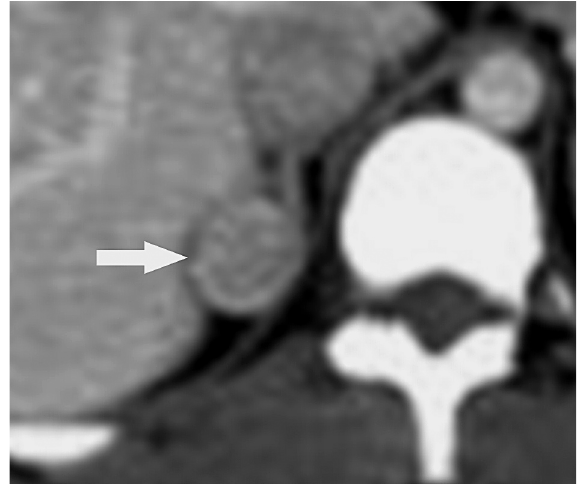
Figure 3 – A) Axial contrast-enhanced portal venous phase CT scan in a 49 year old man with melanoma (Case 3 in Table-1) shows a homogeneously enhancing left adrenal mass (arrow). B) Coronal PET image shows increased fluoro-2-deoxy-D-glucose (FDG) uptake in the mass (arrow). The patient proceeded to laparoscopic adrenalectomy for presumed metastatic disease, with an uneventful intraoperative and postoperative course. Final pathology revealed a diagnosis of pheochromocytoma.